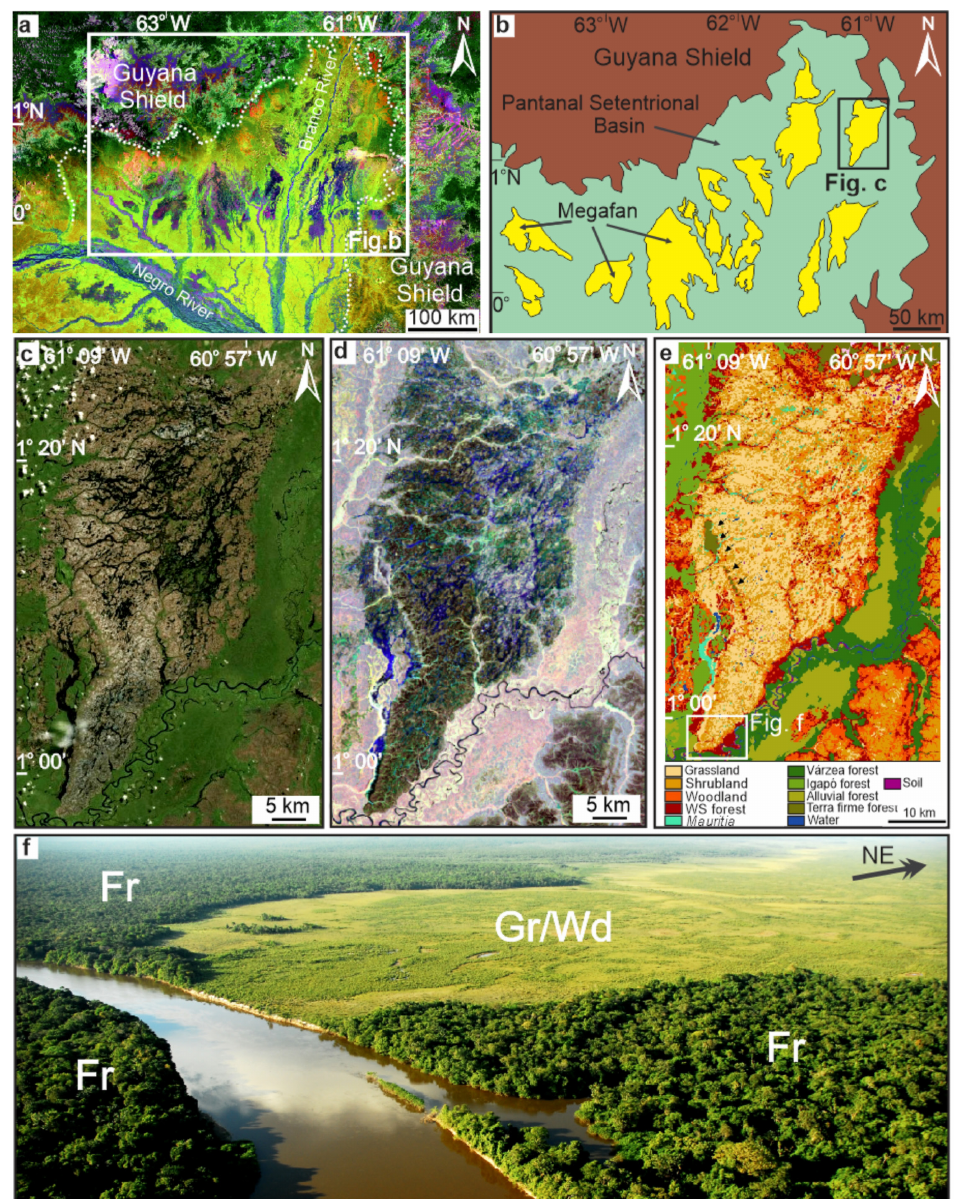
Figure 1 - Megafan paleolandforms of the northern Amazonian wetlands and associated white sand vegetation. a ) General view of several fan-shaped triangular megafan paleolandforms that characterize this region, inserted in the Pantanal Setentrional Basin (contoured by a dotted line). the image is a merger of Landsat and a digital elevation model of the Shuttle radar topography Mission- DEM/SrtM. b ) Line drawing showing a detailed area of this basin where megafans (yellow colour) are abundant (see location in a ). Landsat image of Google Earth tM . c,d ) Details of b showing the fan shape of the Viruá megafan in images of Google Earth tM ( c ) and Advanced Land Observing Satellite (ALOS)-Phased Array type L-band Synthetic Aperture radar (PALSAr) ( d ). e ) Vegetation map of the Viruá megafan paleolandform, which is highlighted by white sand vegetation ranging from grassland to forest (after Cordeiro et al. 2016) in sharp contrast to surrounding areas of rainforest. f) Aerial photograph of the southern end of a megafan (see location in figure e ), illustrating its typical fan shape and vegetation cover consisting of grassland/ shrubland in sharp contrast to the rainforest